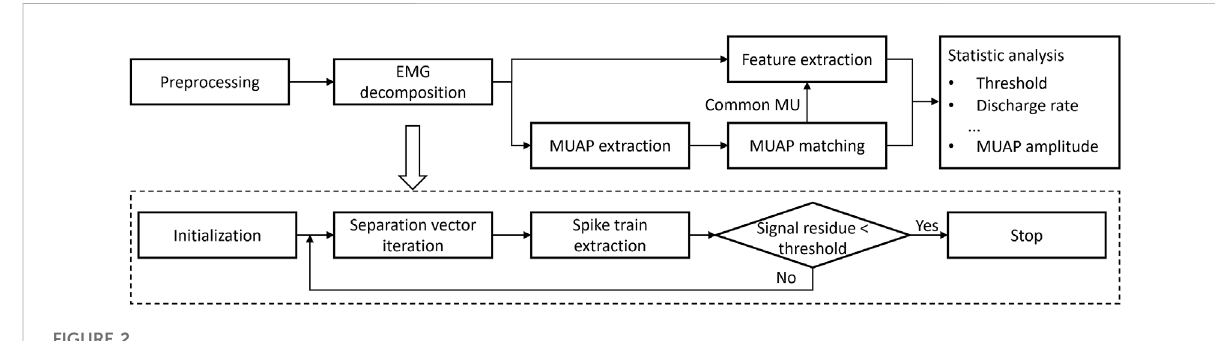
FIGURE 2 The fl owchart of data analysis and EMG